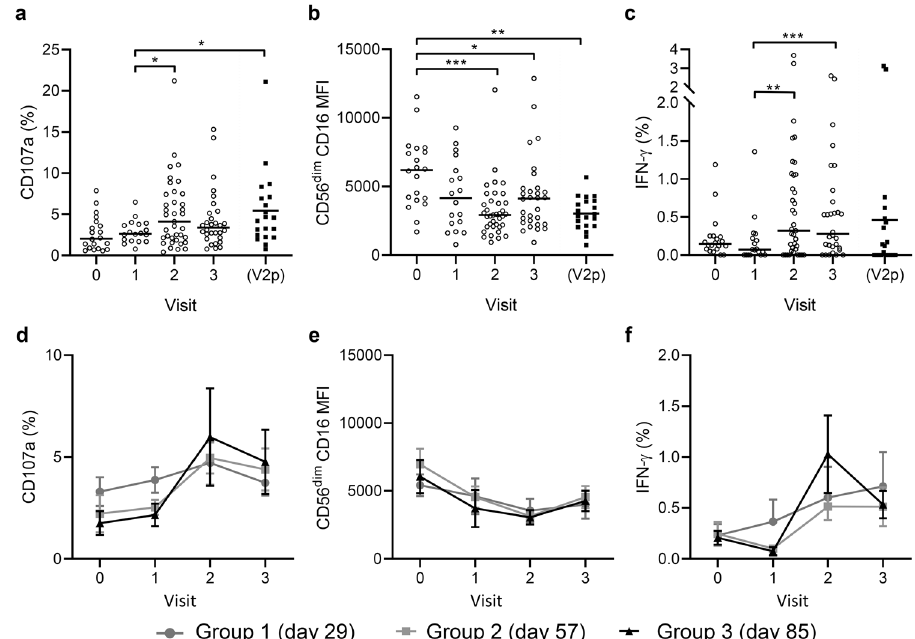
Fig. 4 Antibody-dependent responses of NK cells from individual trial participants using their autologous pre-vaccination and post- vaccination sera. PBMCs collected pre-vaccination (visit 0), post-dose 1 (visit 1), 14 days post-dose 2 (visit 2), and 180 days post-dose 2 (visit 3) were cultured with EBOV GP in the presence of autologous serum from the same visit (or pooled visit 2 serum; V2p) and analysed by fl ow cytometry for CD107a ( a , d ), CD16 MFI ( b , e ), and IFN- γ ( c , f ) expression. Pooled data from all three vaccine groups (see Table 1 for number of participants), data points are shown with a line representing median values ( a – c ). Data according to individual vaccination groups are shown with mean values and s.e.m. Comparisons between visit was performed using one-way ANOVA mixed effects analysis with Geisser – Greenhouse correction. * p < 0.05, ** p < 0.01, *** p <